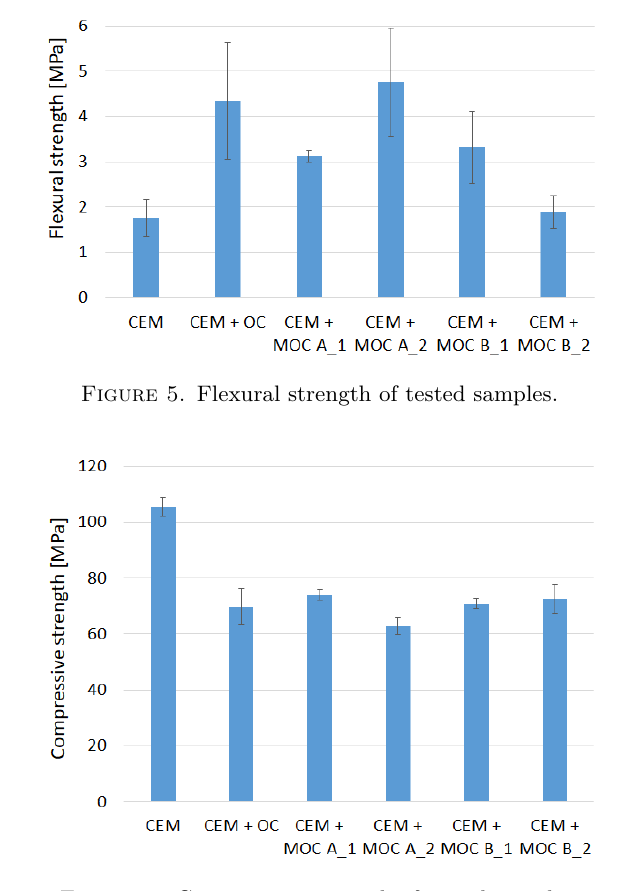
Figure 6. Compressive strength of tested